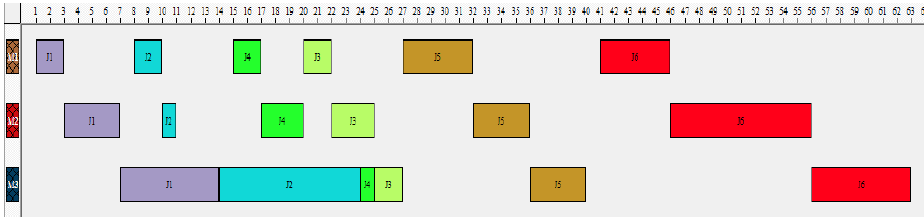
Figure 11. Gantt chart of the best solution with six jobs by B&B.